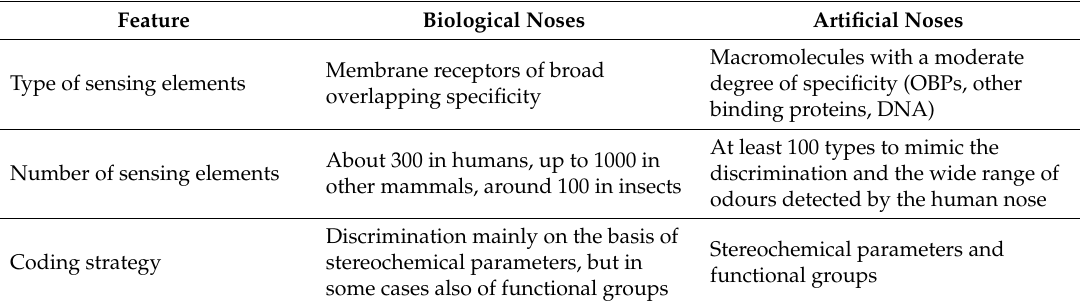
Table 1. Features of biological and artificial